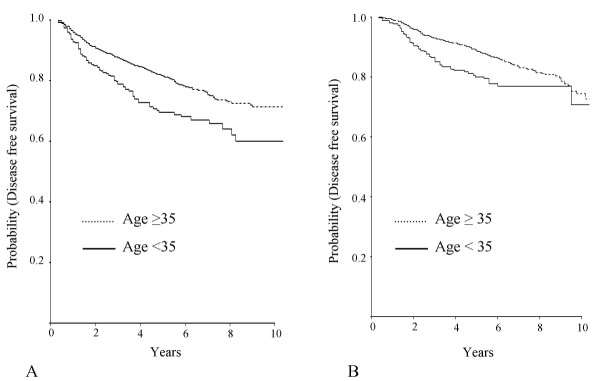
(A) Disease-free survival curves for women <35 vs. ≥ 35 years old. Patients younger than 35 had significantly worse outcomes than their older counterparts (p < 0.001). (B) Overall survival curves showing patients younger than 35 had significantly worse outcomes than their older counterparts (p = 0.002).